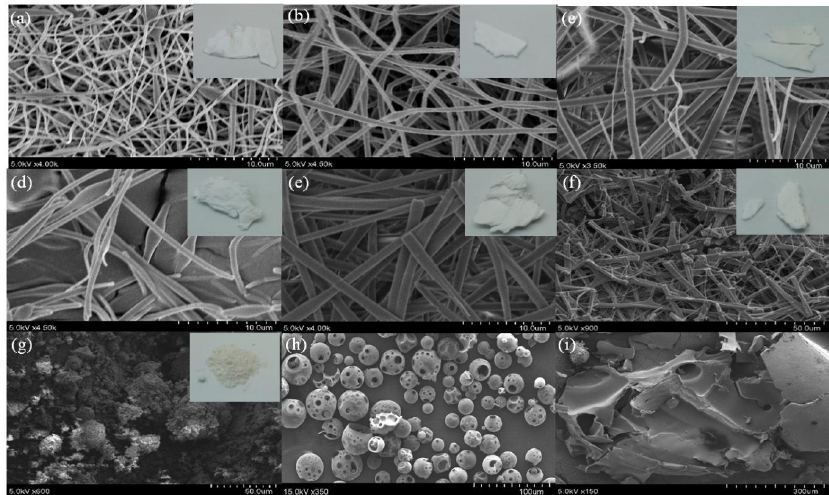
Figure 2. Surface morphology of resveratrol, HPBCD, PVP, and different ratio formulations Figure 2. (Res:PVP:HPBCD) of resveratrol nanofibers, as determined by scanning electron microscopy. ( a )